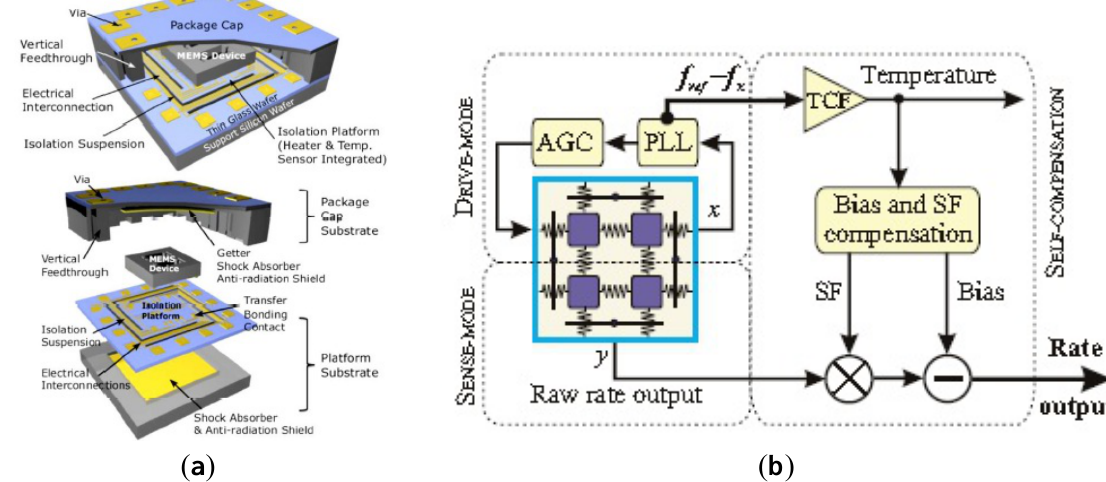
Figure 39. ( a ) University of Michigan vacuum packaging technology. ( b ) UC Irvine temperature